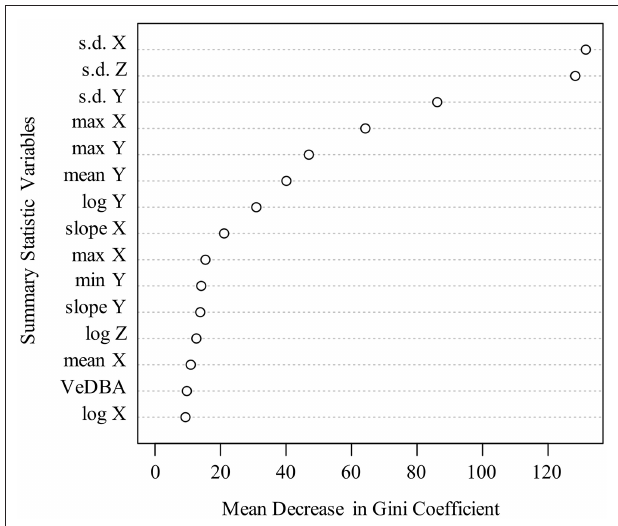
FIGURE 2 | Variable importance plot for optimized Random Forest model used for classification in full ACT datasets. Y-axis depicts top 15 ranked variables (based on mean decrease in Gini, x-axis) out of 23 summary statistics calculated and used in model training. Note that measures of data dispersion (s.d., maximum) were the most informative variables for classification.